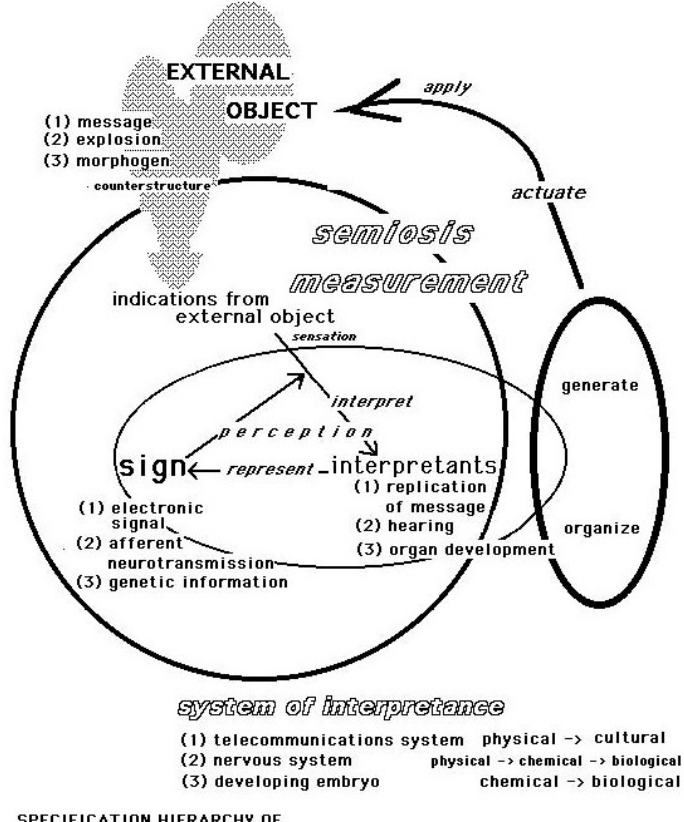
Figure 1. Examples of the generation of meaning during Peircean semiosis for living systems. The building of perception is shown as a developmental